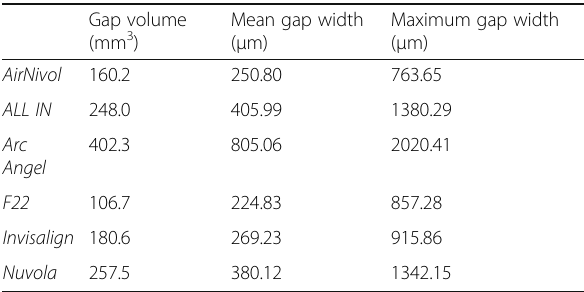
Table 2 3D analysis of each system